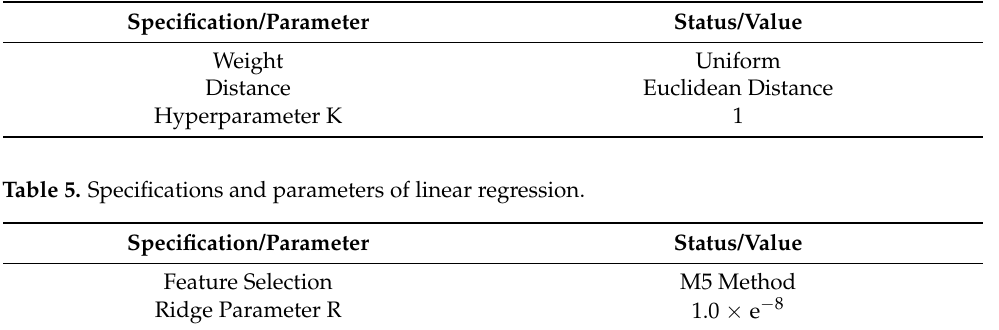
Table 4. Specifications and parameters of k-nearest neighbor (kNN).